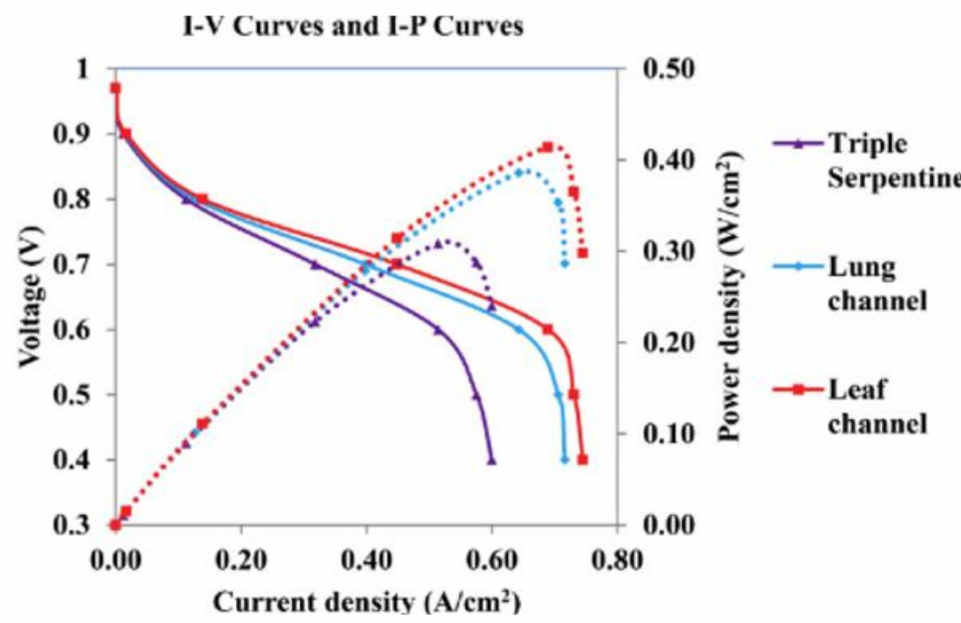
Figure 3. The performance of three-channel designs at the optimum temperature of 75 ◦ C(Reprinted with permission from Ref. [40], license No. 5353090612869).